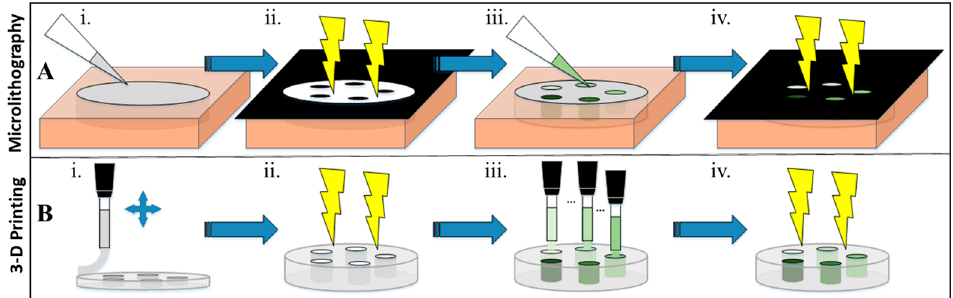
Figure 1. Scheme of microlithographically produced and 3-D printed hybrid hydrogel structures. ( A ) Microlithography: (i) 50 µL of hydrogel cocktail was pipetted into a silicone isolator and then (ii) covered with a mask and crosslinked for 5 min under UV. (iii) The mask was removed, the non-crosslinked cocktail was washed off, and electroconductive hydrogels were pipetted into the wells. (iv) The wells were then covered in a reverse mask and crosslinked for 5 min under UV. ( B ) 3-D Printing: (i) A syringe loaded with a hydrogel cocktail was used to extrusion print the outer part of the hydrogel (layer-by-layer) with a (ii) 30 s UV crosslinking done between each layer. (iii) The five wells were then printed with the electroconductive cocktails and subsequently (iv) UV crosslinked for 5 min.